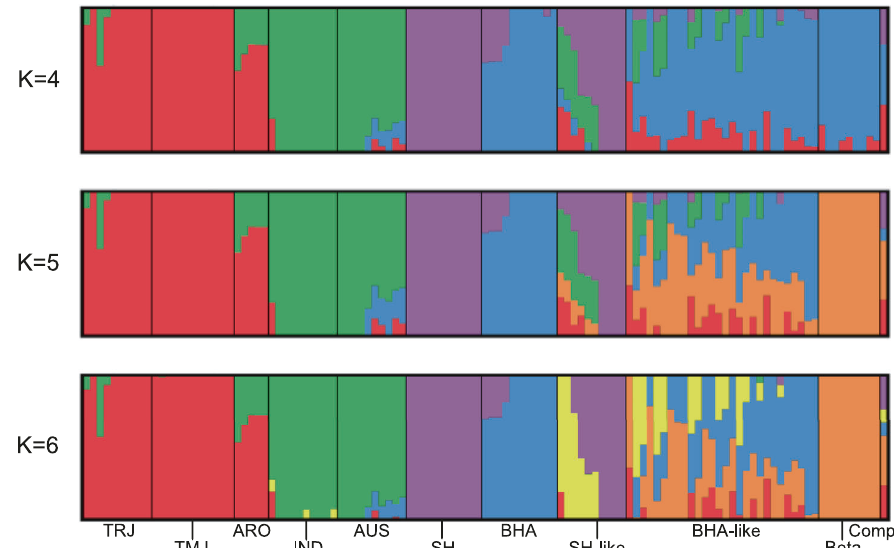
Fig. 2 ADMIXTURE analysis of contemporary weedy rice in the context of historical weedy and cultivated rice. Results of ADMIXTURE analysis of contemporary weedy rice ( n = 48) (SH-like, BHA-like, Beta, Complex) in comparison to historic weedy rice (SH ( n = 11), BHA ( n = 11)) and cultivated rice (TRJ, tropical japonica ( n = 10); TMJ, temperate japonicaI ( n = 12); ARO, aromatic ( n = 5); IND, indica ( n = 12); AUS , aus ( n = 10)). Values of K at 4, 5, and 6 are shown; K = 6 is the optimal value based on cross-validation error. Categories for contemporary weeds are based on predominant weedy ancestry. The four solid bars within the SH-like group represent the contemporary weeds without genome-wide evidence of hybridization. Table 1 Average genome bias of contemporary weedy